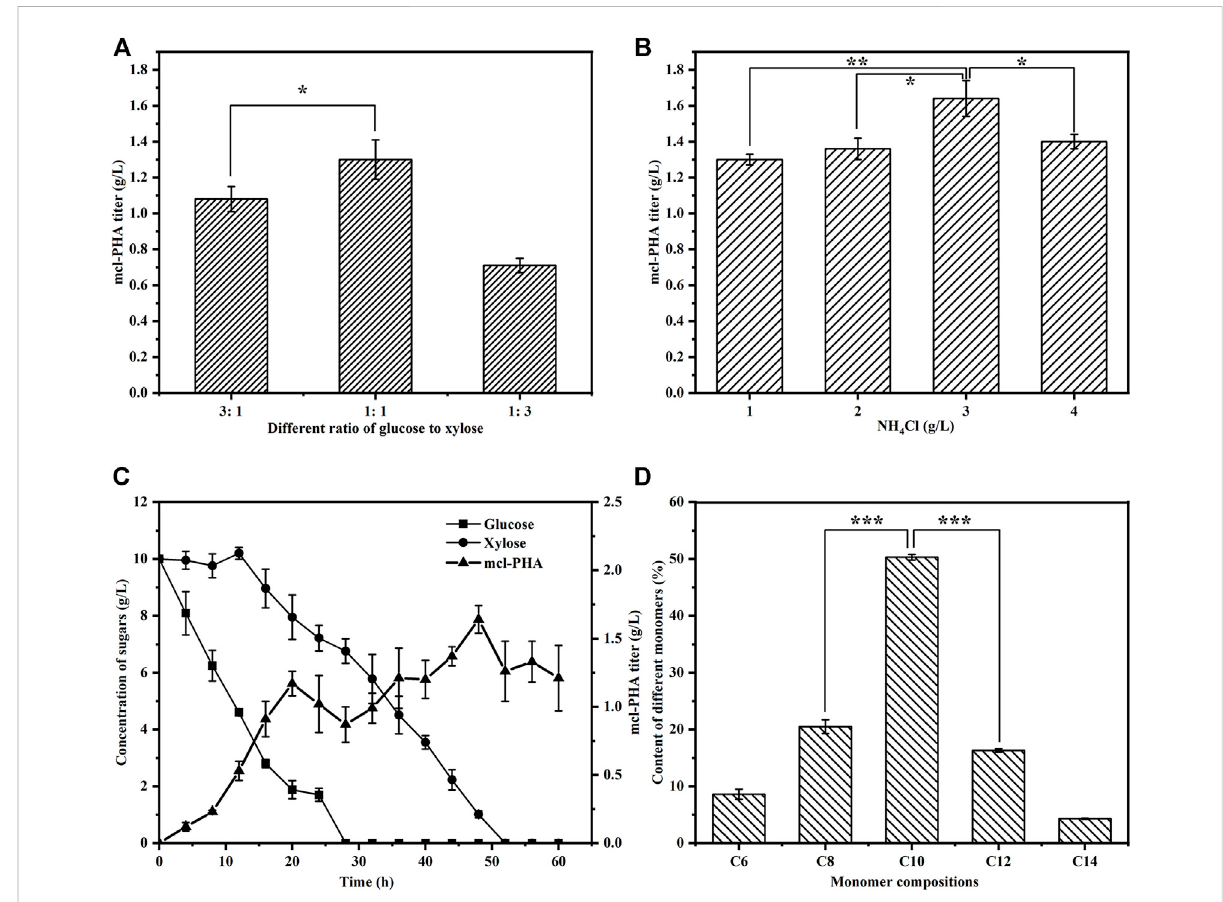
FIGURE 5 The production of mcl-PHA by the P. putida - E. coli microbial consortium using M9 medium with added glucose and xylose. (A) The mcl-PHA titerinthemicrobialconsortiumwithdifferentmixedsugarratiosandthetotalconcentrationsofmixsugarswere20 g/L. (B) Themcl-PHAtiterinthe microbial consortium at different nitrogen concentration. (C) The residual contents of different sugars by the microbial consortium. (D) The monomer composition of mcl-PHA produced by the microbial consortium. The error bars indicate the standard deviation of